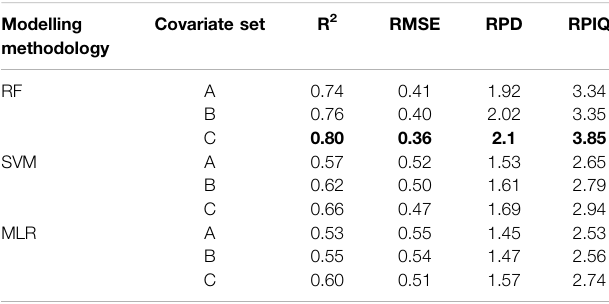
TABLE5| PerformanceresultsofRF,SVM,andMLRinpredictingSOMbasedon different combinations of covariates. The bold values are the precision of the optimal